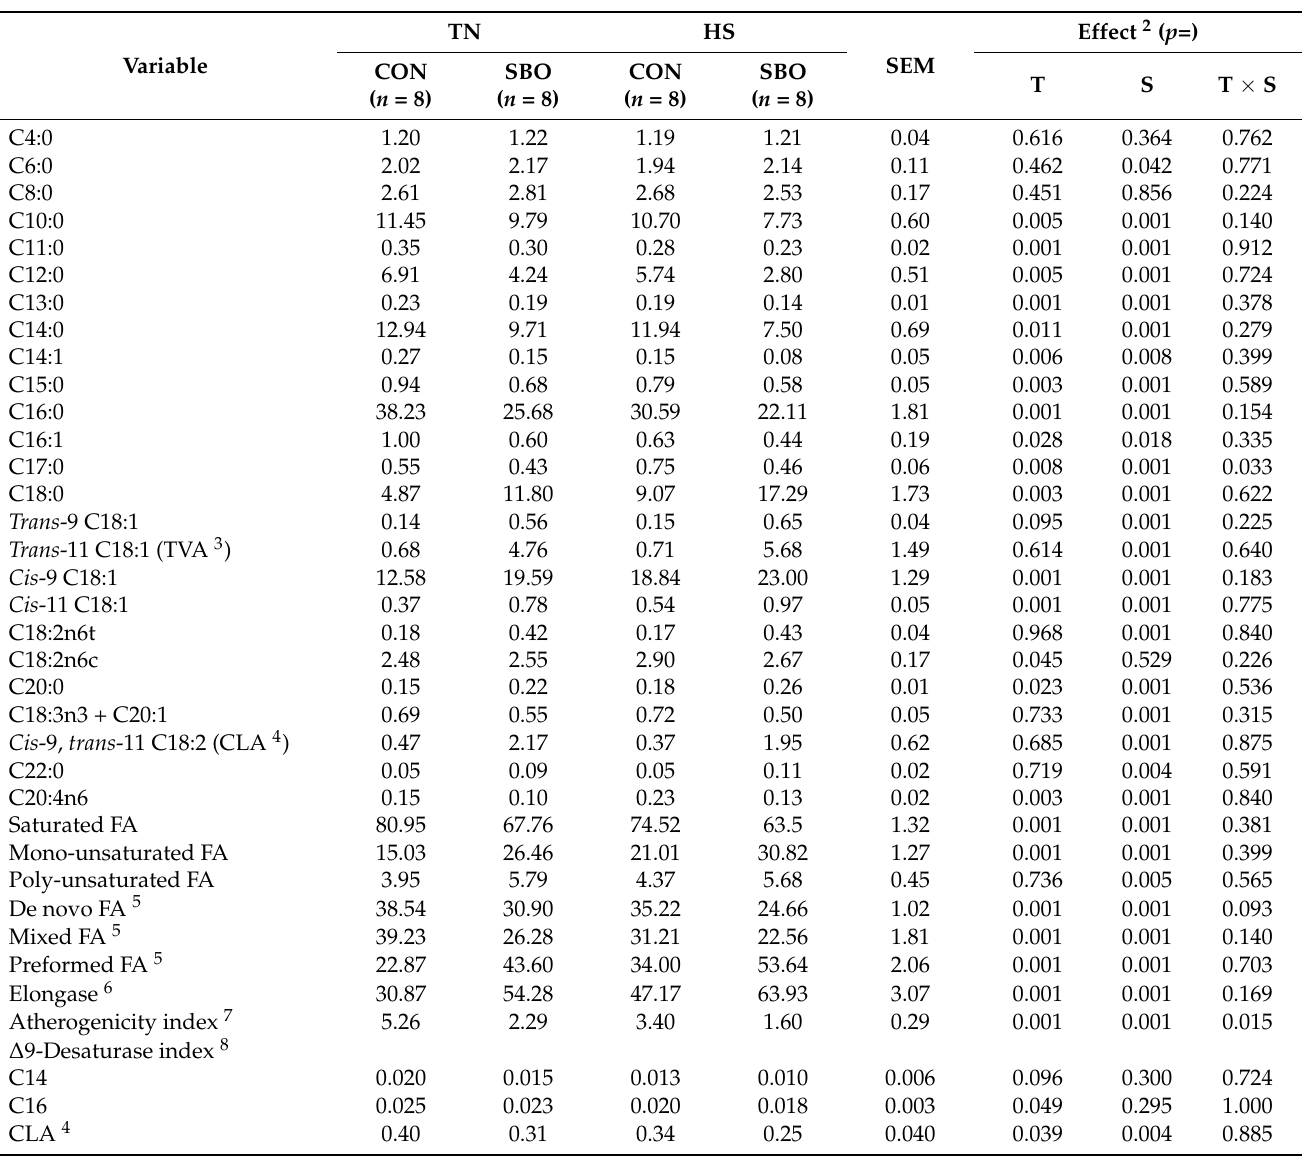
Table 3. Least squares means for milk fatty acids (FA) expressed as % of total FA methyl esters in dairy goats under thermoneutral (TN) and heat stress (HS) conditions. In each ambient temperature goats were fed a control diet (CON) or supplemented with 4% soybean oil (SBO) 1